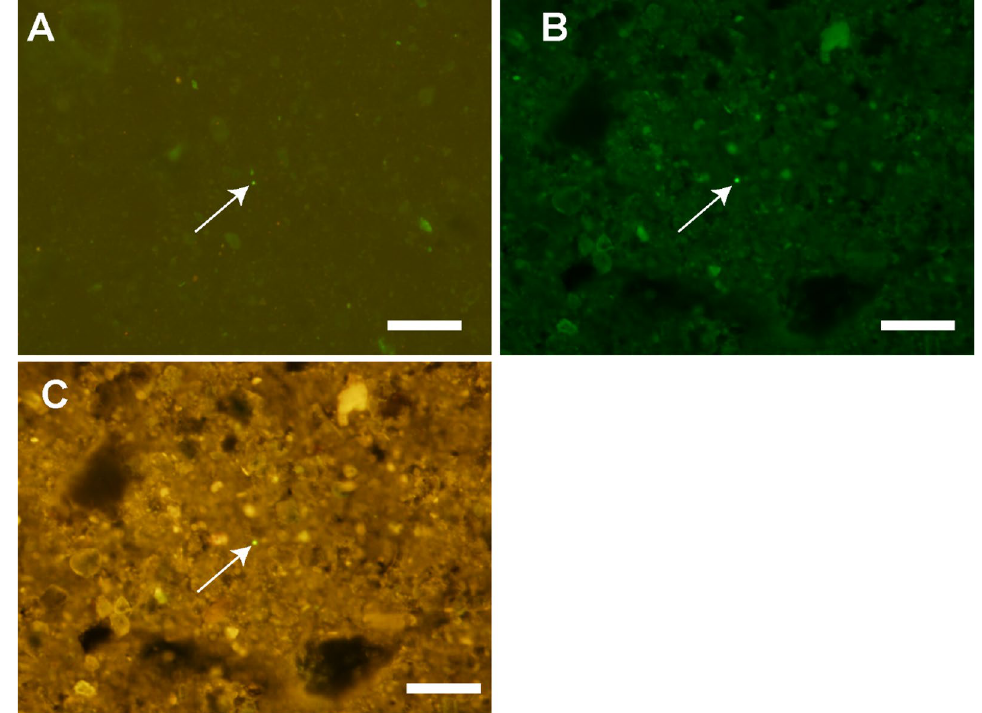
Fig. 1 Examples of fluorescence microscopy images. Sediment samples obtained by International Ocean Discovery Program (IODP) Expedition 370 (T-limit) at 207.5 mbsf (3F-3) was stained with AO ( A ) and SYBR-I ( B , C ). B and C show the same position of the prepared membrane observed with optical emission filter that passes only wavelength around 525 nm ( B ) and without emission filter ( C ). It is noted that only single cell (pointed by white arrows) is present in the area of each image. Bars represent 5